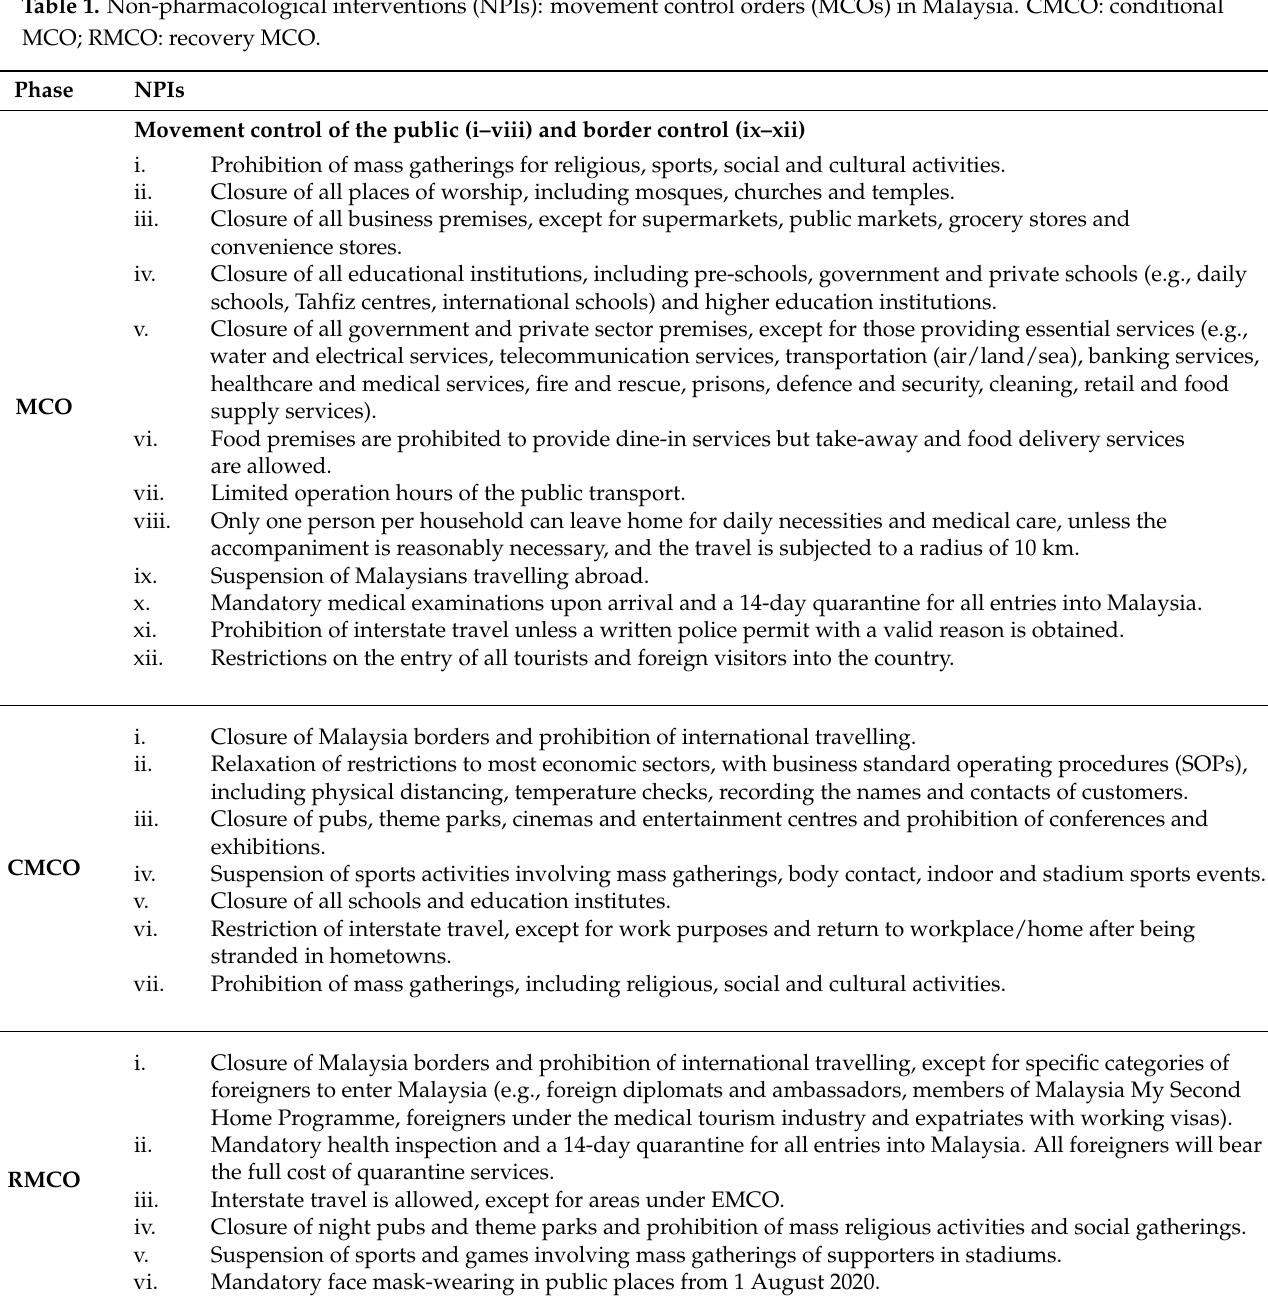
Table 1. Non-pharmacological interventions (NPIs): movement control orders (MCOs) in Malaysia. CMCO: conditional MCO; RMCO: recovery MCO. Phase